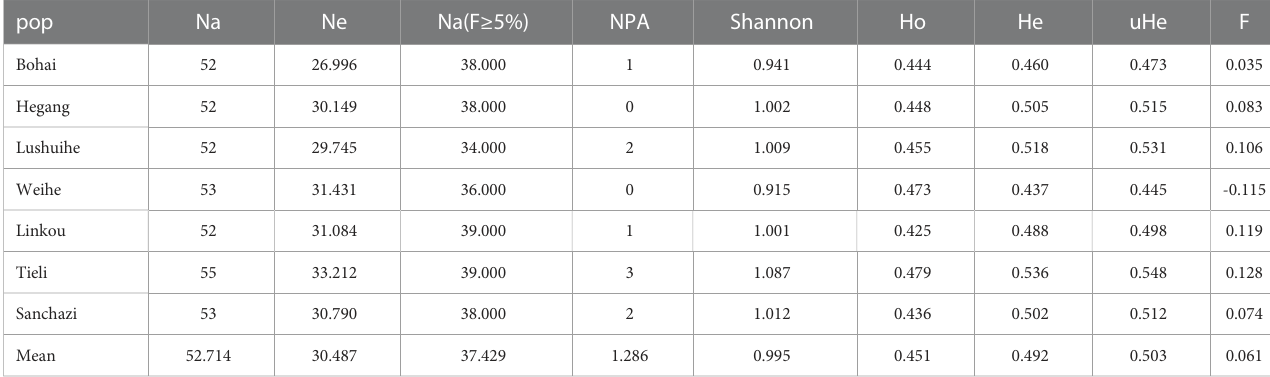
TABLE 5 Genetic parameters of 7 Korean pine